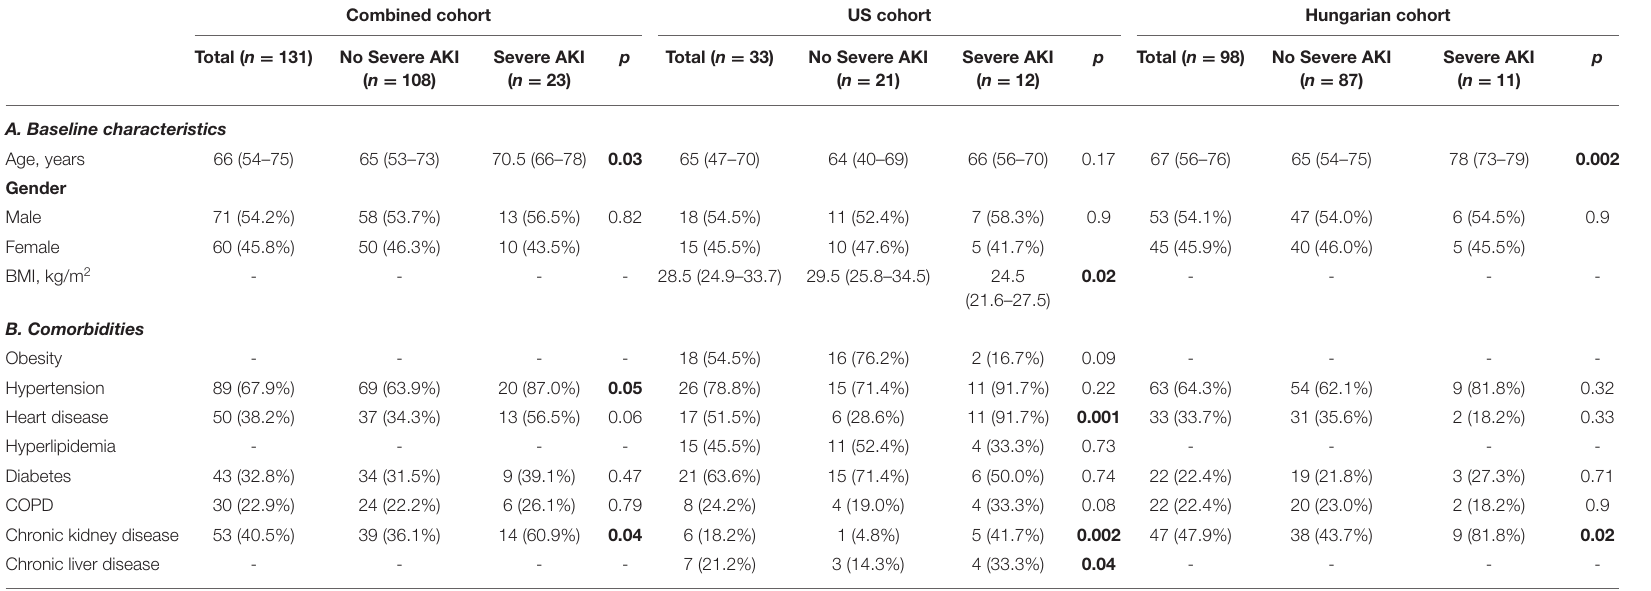
TABLE 1 | Baseline characteristics (A) and comorbidities (B) in hospitalized COVID-19 patients in US and Hungary, stratified according to development of severe